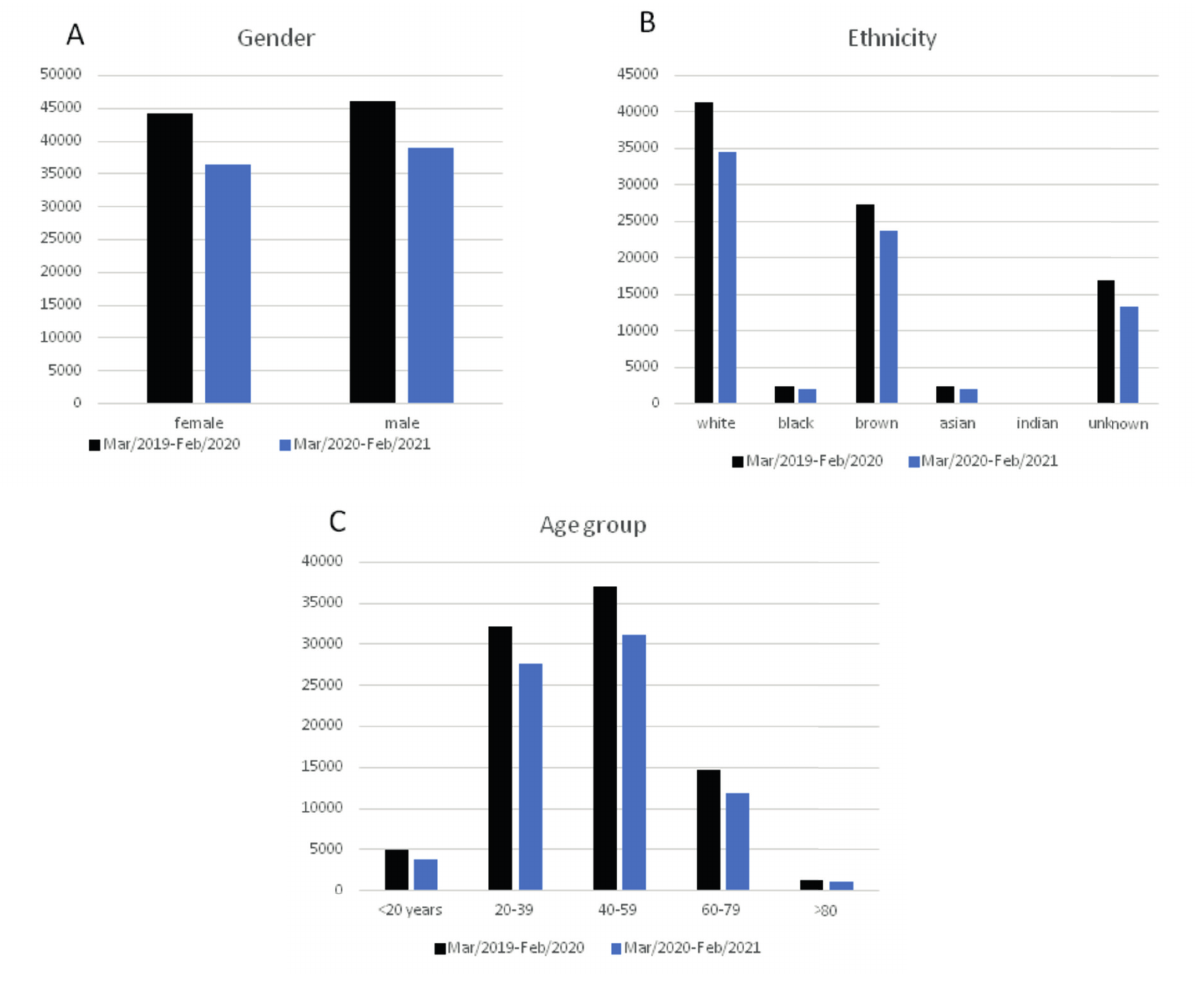
Figure 2 - Effect of the COVID-19 outbreak in hospital admissions for urolithiasis according to gender (A), ethnicity (B), and age